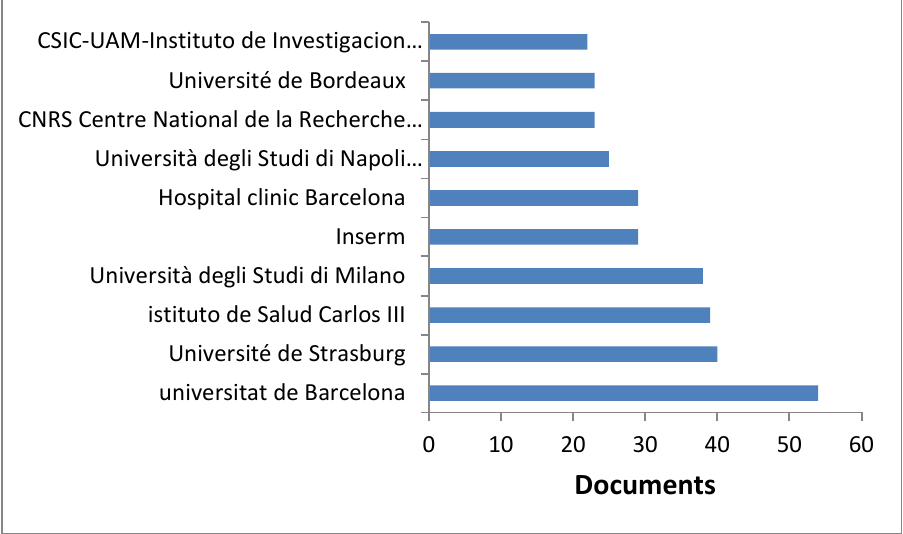
Figure 5. Most productive institutions. (Bibliometric data were extracted from the Scopus online database).